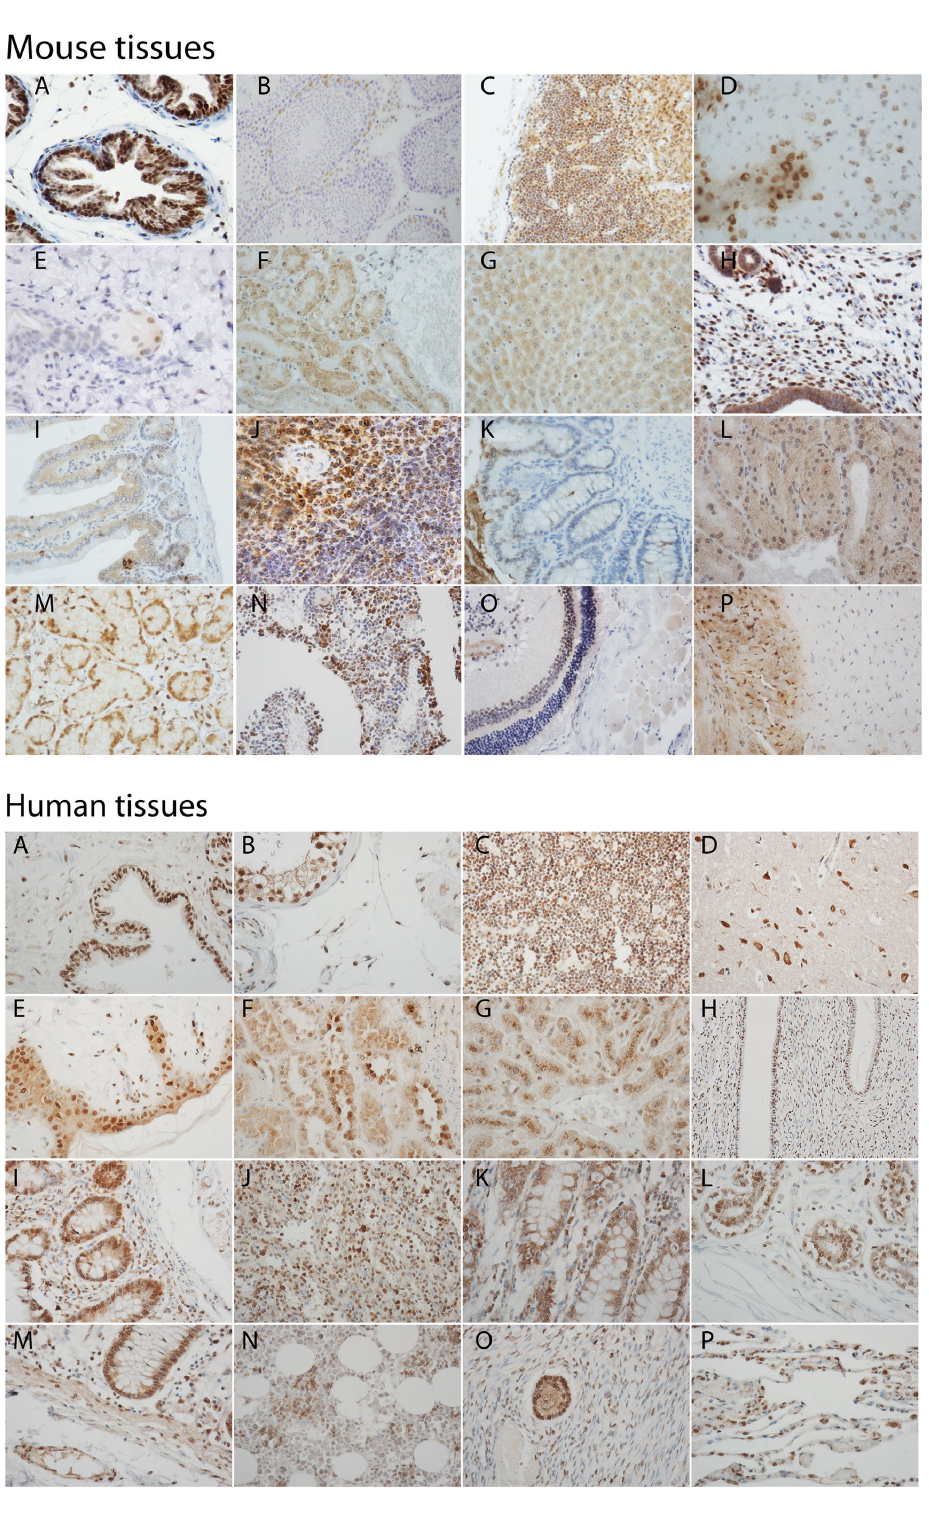
Figure 7. Upper panel - Mouse tissues: A, prostate; B, testis; C, thymus; D, brain; E, skin and hair follicle; F, kidney; G, liver; H, uterus; I, intestine; J, spleen; K, colon; L, lacrimal gland; M, salivary gland; N, bone marrow; O, eye; P, heart. Lower panel - Human tissue: A, prostate; B, testis; C, thymus; D, brain; E, skin; F, kidney; G, liver; H, uterus; I, intestine; J, spleen; K, colon; L, breast; M, intestine and omentum; N, bone marrow; O, ovary and follicle; P, lung. doi: 10.1371/journal.pone.0071694.g007 PLOS ONE |